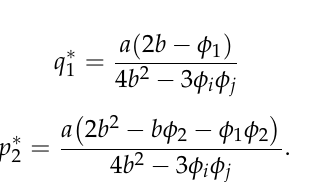
Figure 14. Firm 2’s Best ‐ Reply Curve in the Cournot ‐ Bertrand Model When CEO 2 Underestimates Product Substitutability.